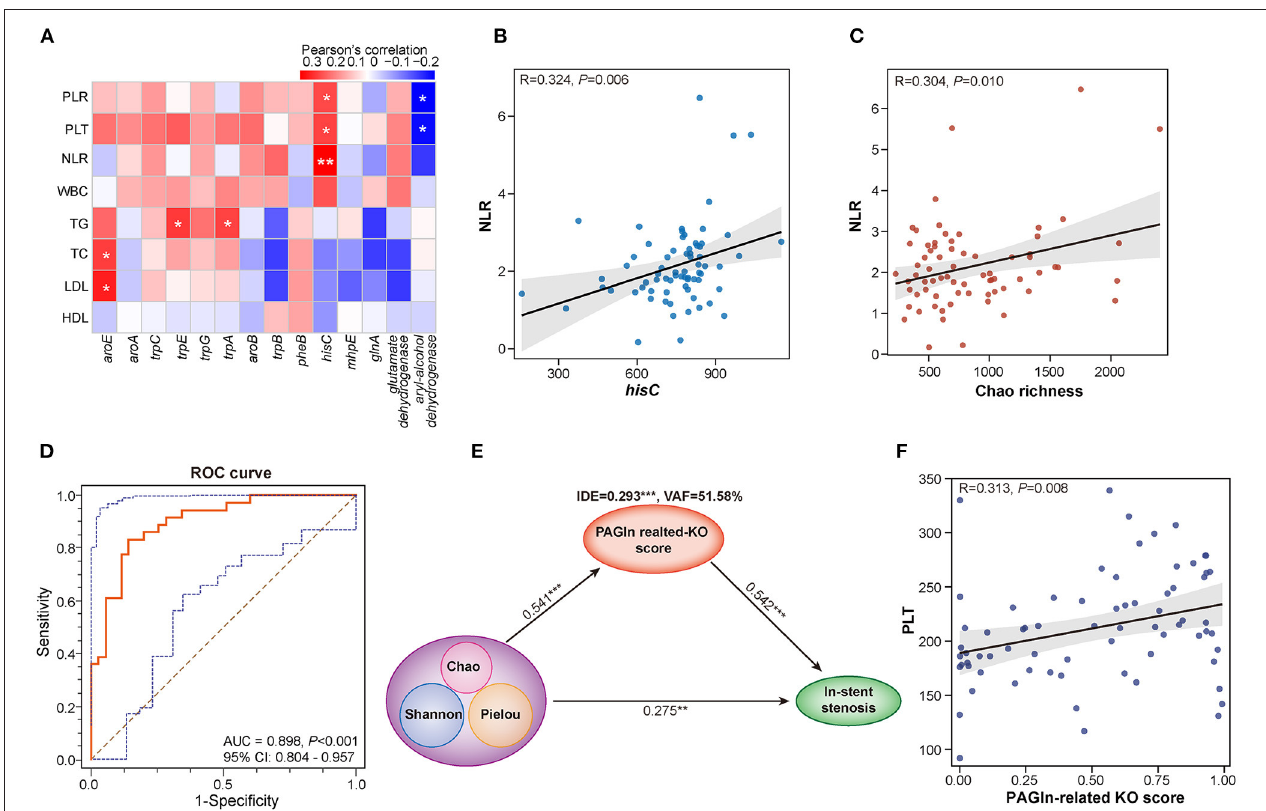
FIGURE 4 | Interactions among gut microbiota, PAGln synthesis-related enzyme genes, clinical parameters, and in-stent stenosis in CAD patients. (A) Heatmap shows the Pearson’s correlation between PAGln-related synthetic enzyme genes and clinical parameters, including NLR, PLT, PLR, WBC, TG, TC, LDL, and HDL. (B) Positive correlation between hisC and NLR (R = 0.324, P = 0.006). (C) Positive correlation between Chao richness and NLR (R = 0.304, P = 0.010). (D) ROC curve for the KO score based on 14 PAGln-related synthetic enzyme genes/KOs (AUC = 0.898, P < 0.001, 95% CI: 0.804–0.957). (E) PLS-SEM models show